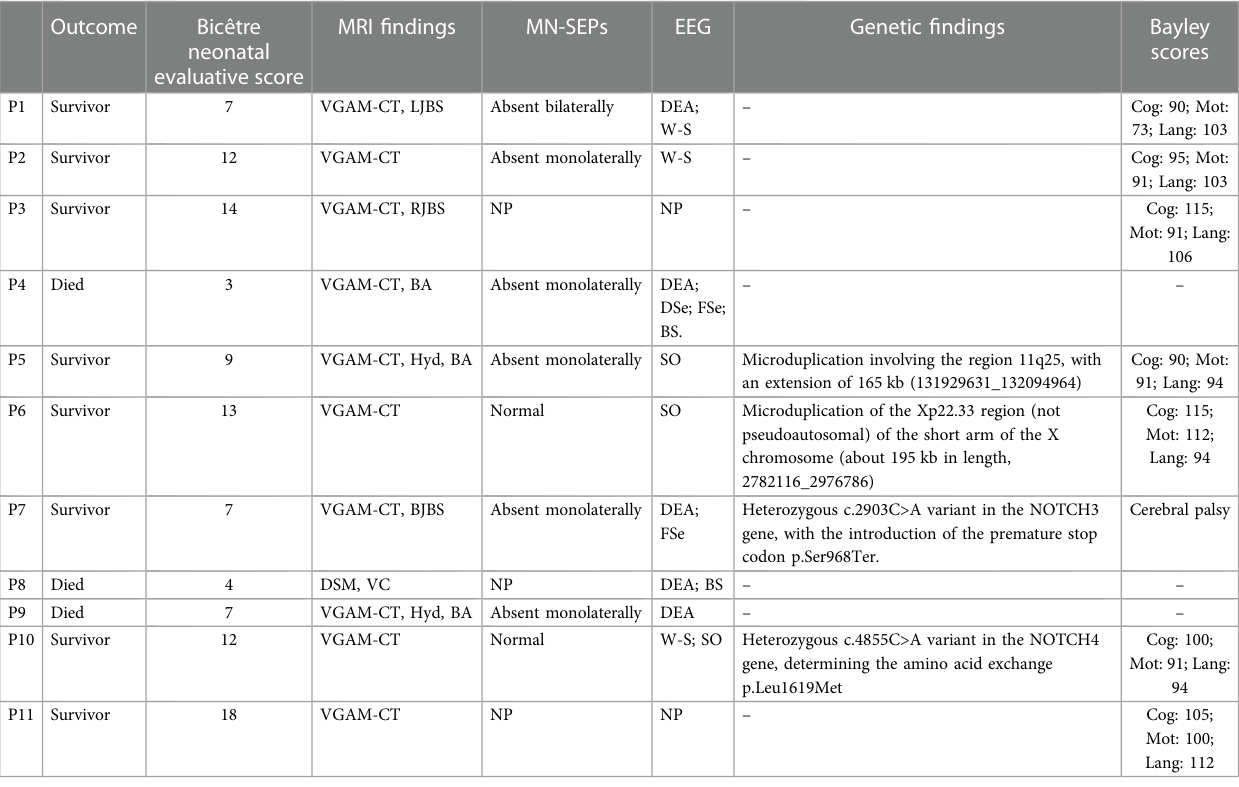
TABLE 2 Outcome, Bicêtre neonatal evaluation score, neuroimaging fi ndings, median nerve somatosensory evoked potentials (MN-SEPs), electroencephalogram fi ndings, genetic fi ndings, and Bayley-III